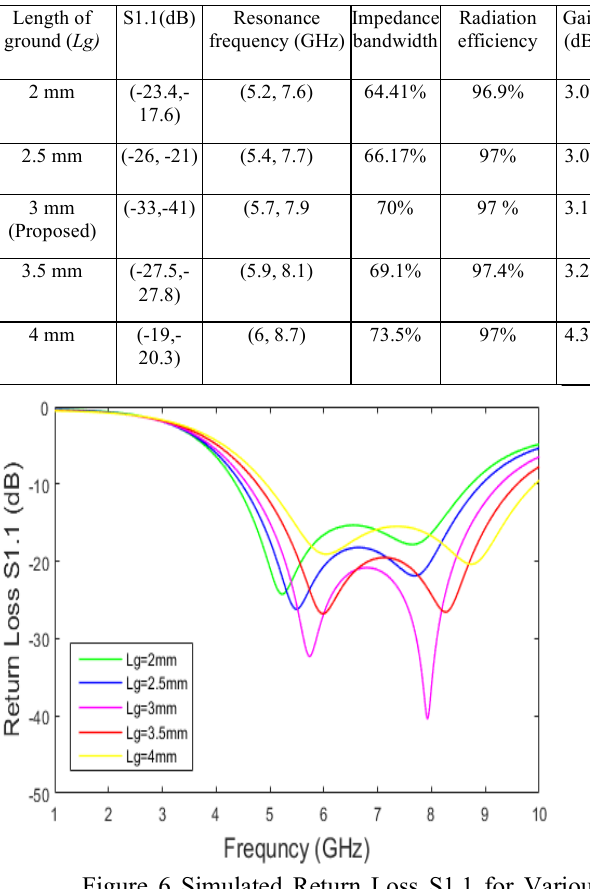
Table 3: Comparison of proposed model based on L g . Length of S1.1(dB) ground ( Lg)